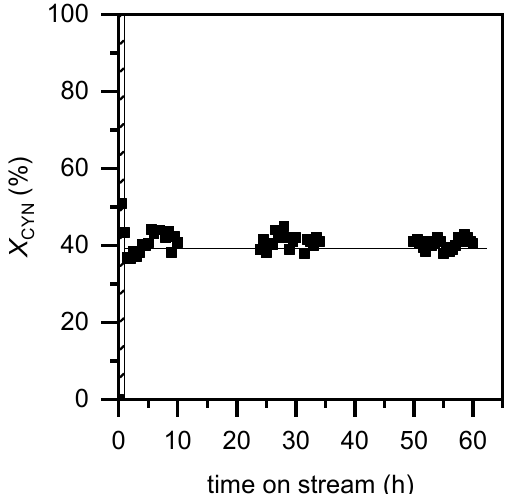
Figure 6. Long-term performance of the catalyst upon CWPO of CYN (flow rate = 0.2 mL min − 1 ,